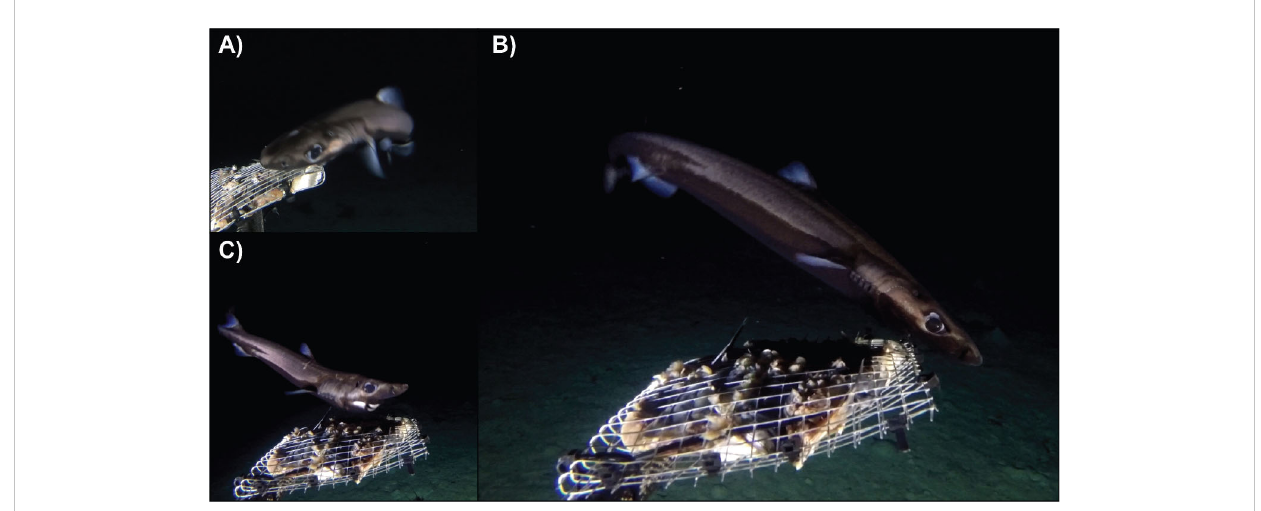
FIGURE 2 In-situ images of Etmopterus bigelowi from deep waters of the Cayman Islands collected using deep-sea video landers (Phillips et al., 2019). One male individual was observed on July 26 th 2022 (A) followed by observations of a male (B) and female (C) on September 19 th 2022. The individuals made several passes across the fi eld of view and were observed interacting with the bait cage.